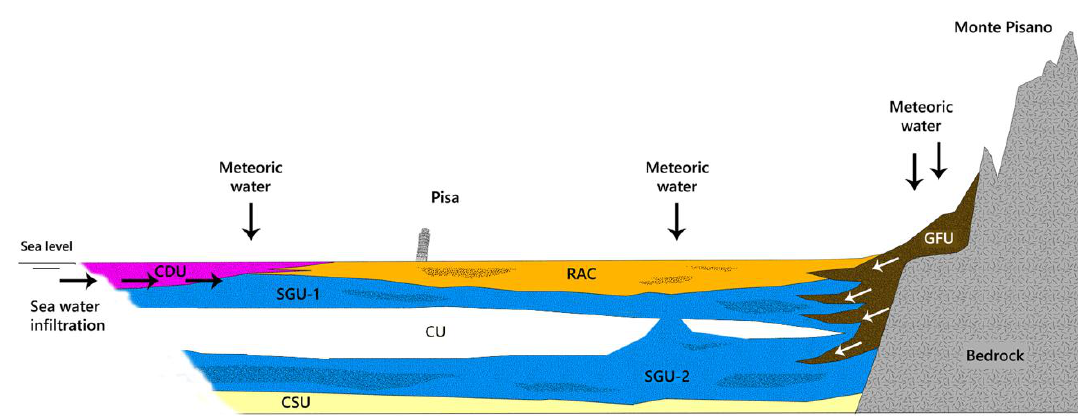
Figure 3. Subsoil conceptual model of the Pisa plain. CDU: coastal dune unit; RAC: recent alluvial cover; GFU: gravel fans unit; SGU-1: sands and gravels upper unit; SGU-2: sands and gravels lower unit; CU: clay unit; CSU: clay and sands unit. SGU-1 and SGU-2 form a multilayered aquifer (SGU). Clay and Sands Unit (CSU): clayey and sandy sediments below the SGU. Just a few deep